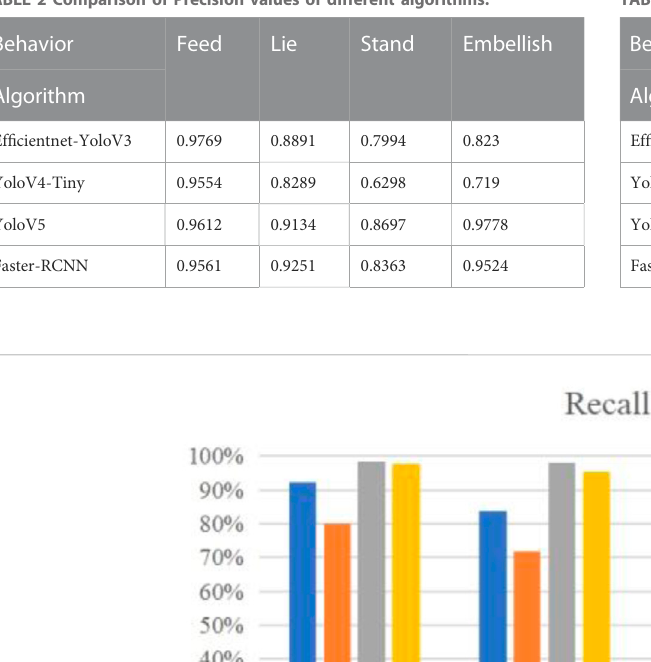
TABLE 3 Comparison of Recall values of different